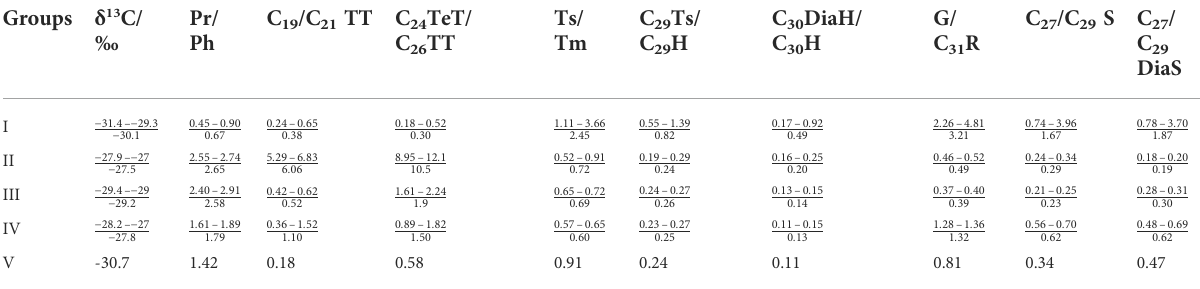
TABLE 1 Summarized ranges and averages of biomarker parameters and whole oil/extracts carbon isotopes for sample groups. Groups δ 13 C/